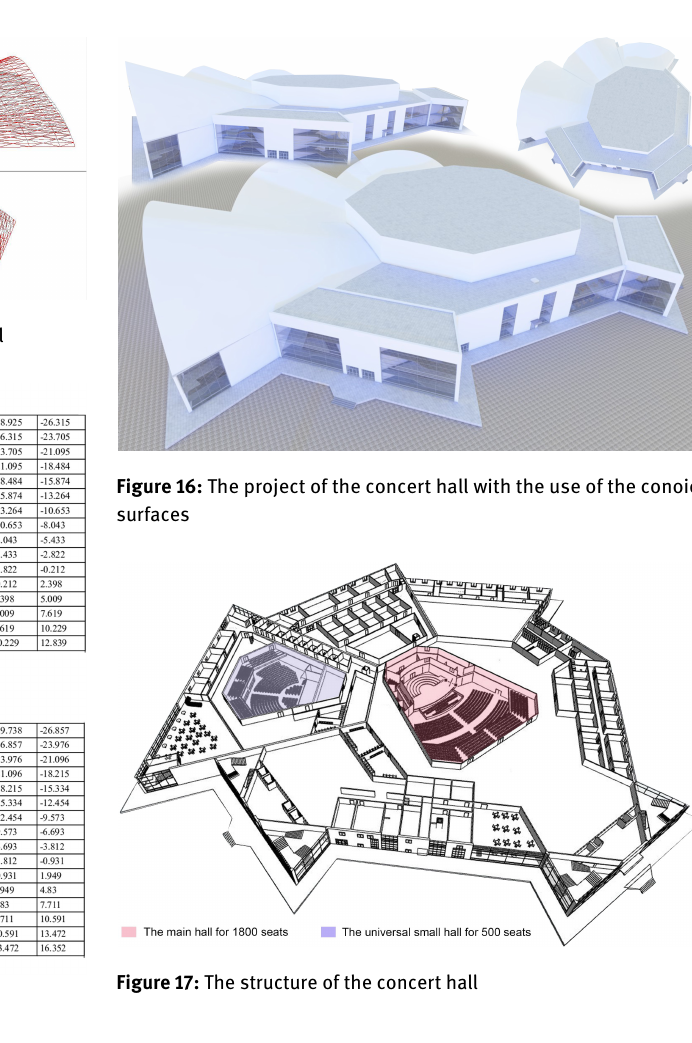
Figure 15: The z-axis deformation